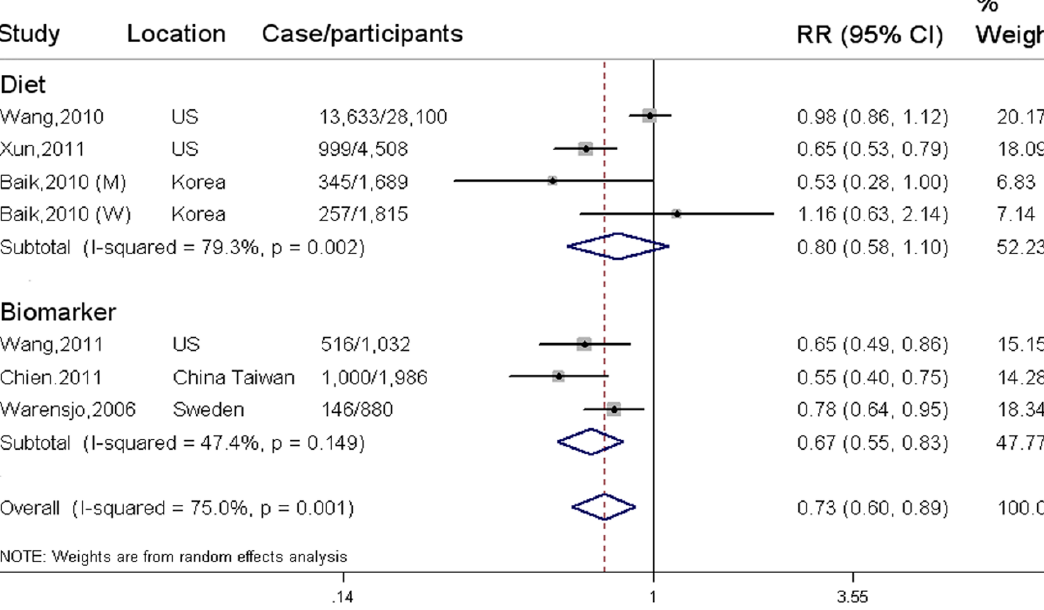
Figure 3. Associations between LC n -3 PUFA and incidence of elevated BP in the highest verse the lowest exposure category.